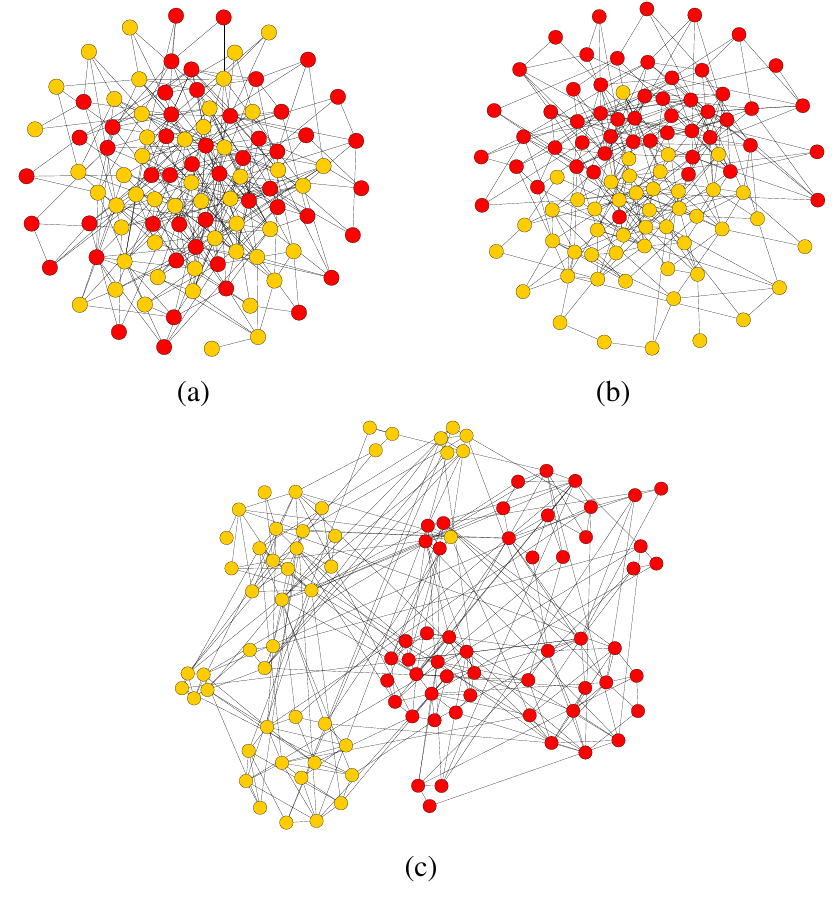
Figure 3. (a) The simulation starts from a random network with N = 100 and 50 players for each type. (b) In the first short part of the simulation ( ∼ 500 time steps) the strategies reach an equilibrium, the network however is still unorganized. (c) The community structure starts then to emerge, many small clusters with nearly uniform strategy